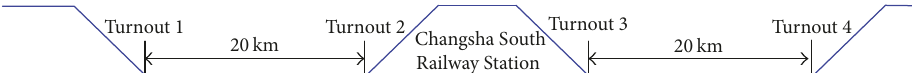
Figure 6: High-speed railway network.